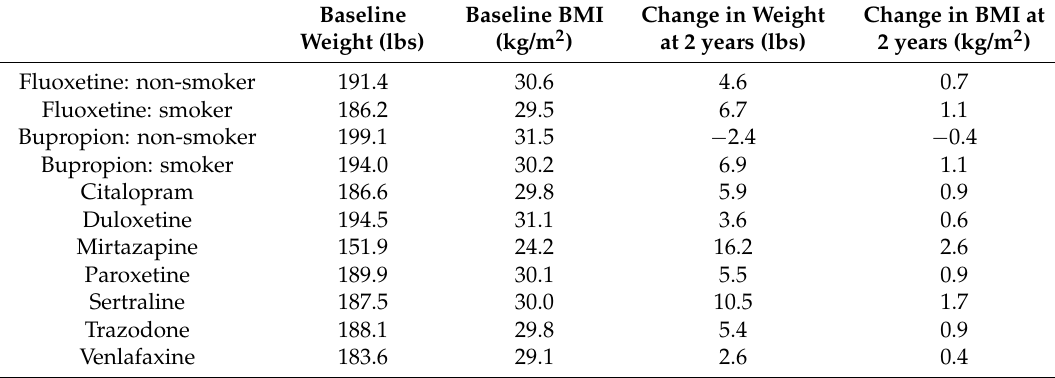
Table 3. Estimated baseline weight and body mass index (BMI) and change in weight and BMI at 2 years